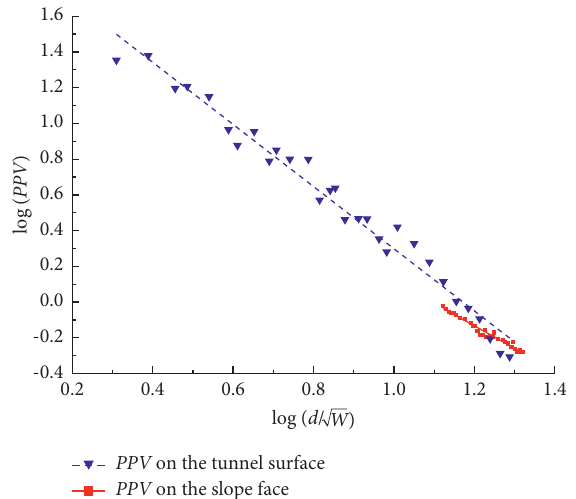
Figure 16: Vector PPV versus scaled distance based on the nu- merical simulation.